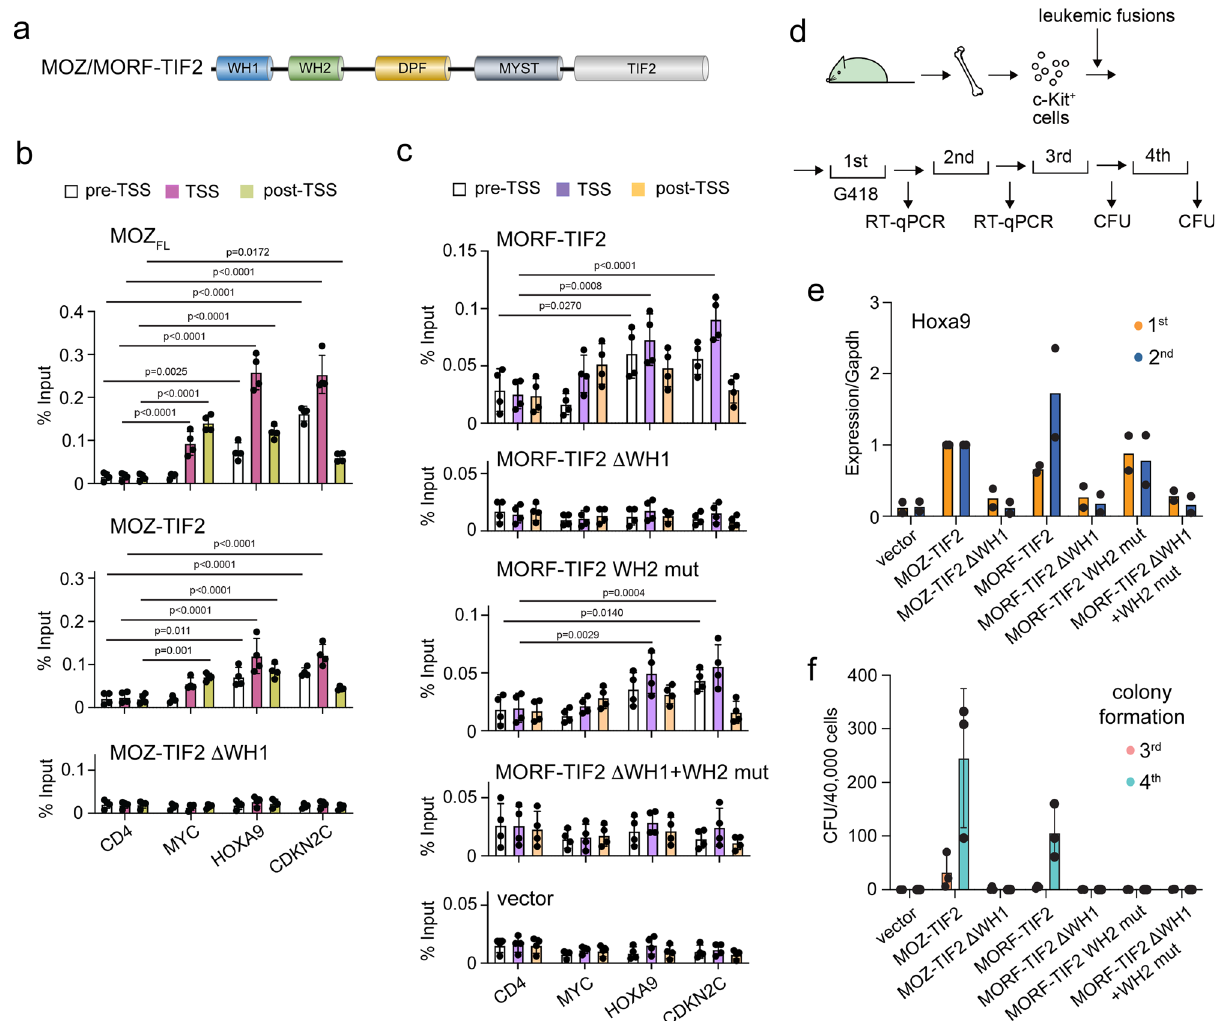
Fig. 6 | MOZ/MORFWH1-mediated association with unmethylated CpG-rich gene promoters is essential for leukemic MOZ/MORF fusions. a Schematic of the MOZ/MORF-TIF2 fusion. b Localization of the indicated MOZ-TIF2 proteins at CD4,MYC,HOXA9 ,and CDKN2C genes. ChIP-qPCRwas performed fortheindicated genelociusingqPCRprobesdesignedforthepre-TSS( − 1to − 0.5kbofTSS),TSS(0 to +0.5kb of TSS), and post-TSS regions (+1 to +1.5kb of TSS) of each gene. ChIP signals are expressed as a percentage of input (mean±SD of four technical repli- cates; n =4).2wayANOVAwasperformedandthestatisticalsigni fi canceoftheChIP signals to the non-target gene CD4 is shown. P values are shown above